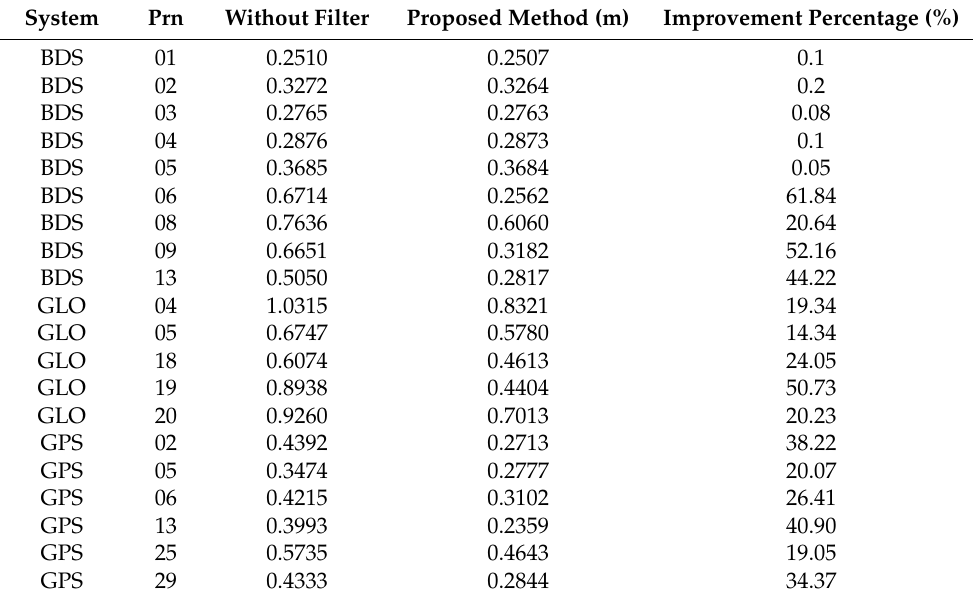
Table 2. Standard deviation of pseudorange